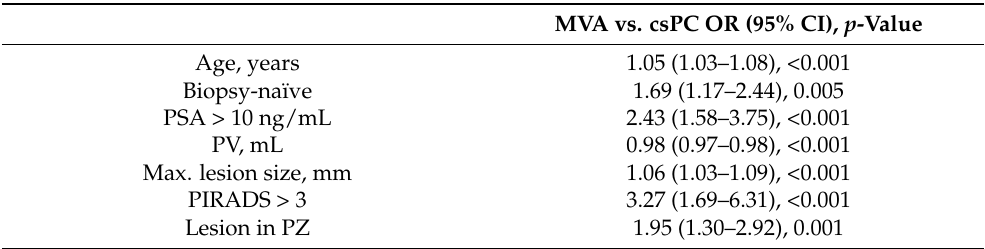
Table 3. Association between clinically significant prostate cancer (csPC) diagnosis and other factors, digital rectal examination (DRE) excluded.